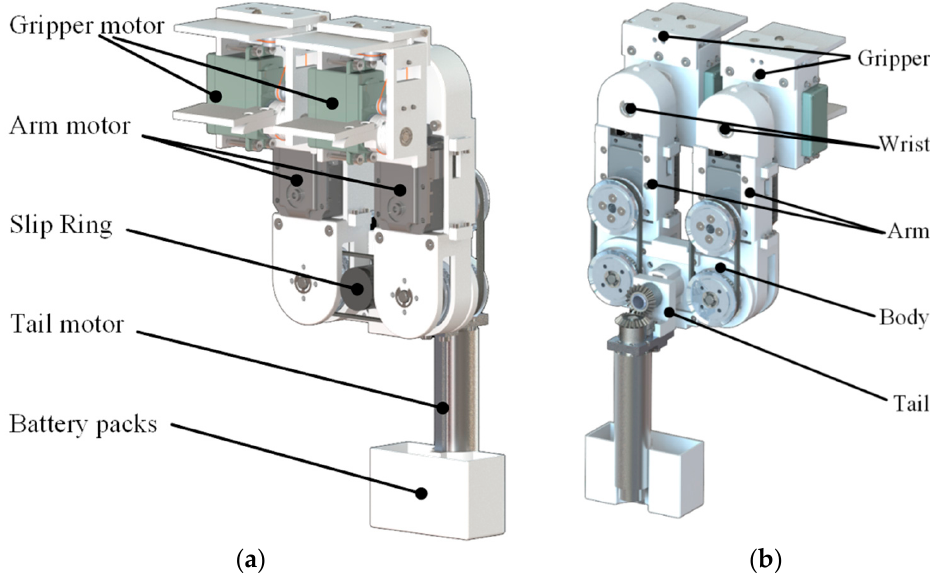
Figure 7. Three-dimensional CAD drawing of proposed transverse brachiation robot: ( a ) front view; ( b ) back view. ( b ) back